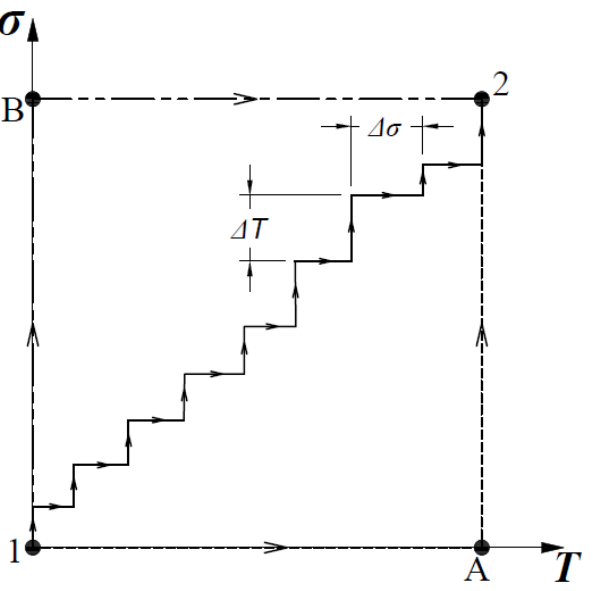
Figure 2. Potential temperature–stress paths between initial and final conditions of the fire-exposed members.